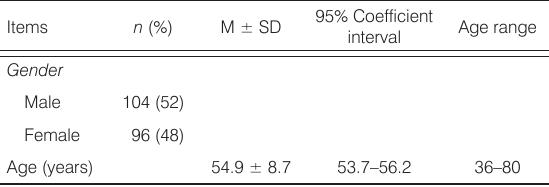
Table 1. Demographic characteristics of participants ( n = 200).